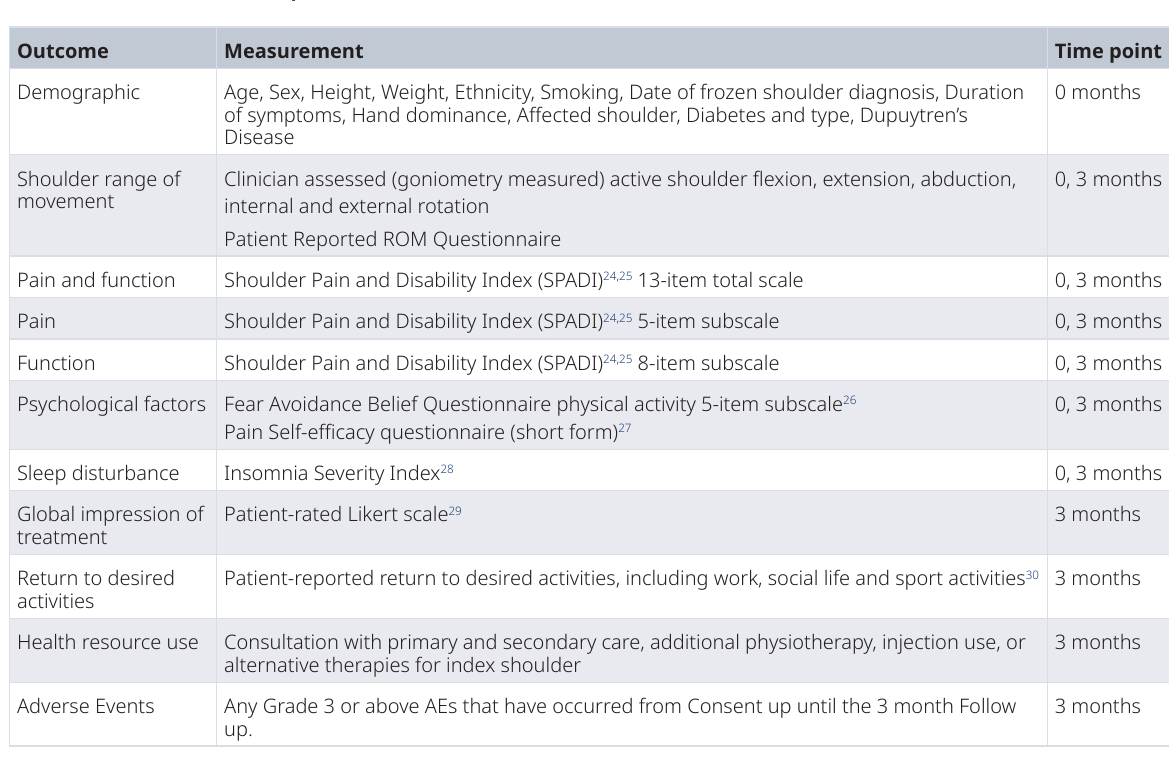
Table 1. Outcomes and time points of